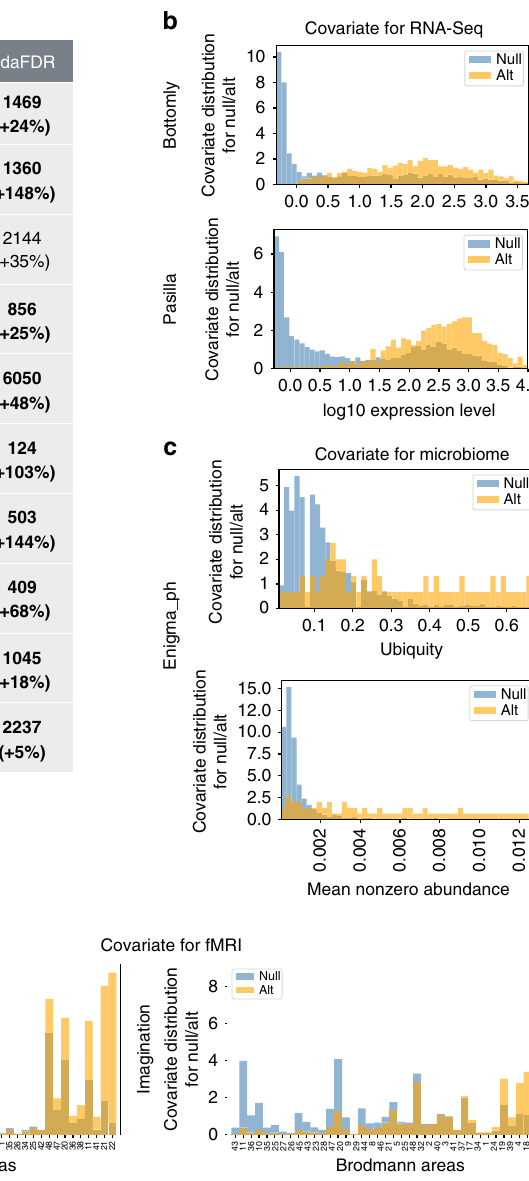
Fig. 3 Results on other applications. a The number of discoveries of various methods on two small GTEx eQTL datasets, three RNA-Seq datasets, two microbiome datasets, one proteomics dataset, and two fMRI datasets. AdaFDR is used for the small GTEx and the RNA-Seq datasets while AdaFDR-fast is used for others, due to their smaller data size. The fMRI results for AdaPT are omitted since the AdaPT software does not support categorical covariates. b Covariate visualization for RNA-Seq datasets. c Covariate visualization for the microbiome dataset. d Covariate visualization for the proteomics dataset. e Covariate visualization for fMRI